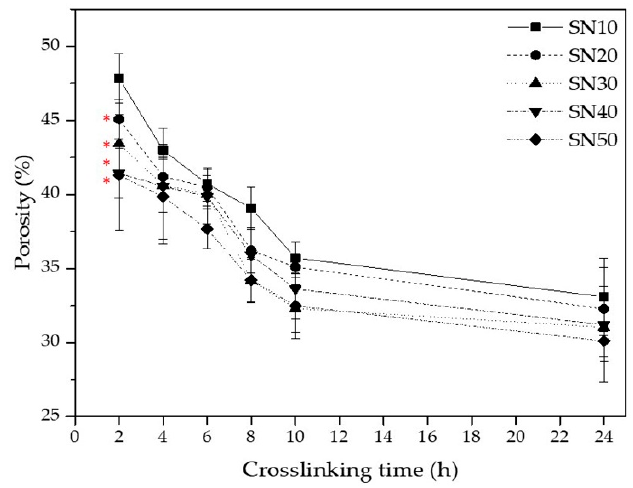
Figure 4. Porosity of SN starch hydrogels at various crosslinking times and GA contents ( n = 3 , * p < 0.05 compared with SN10).